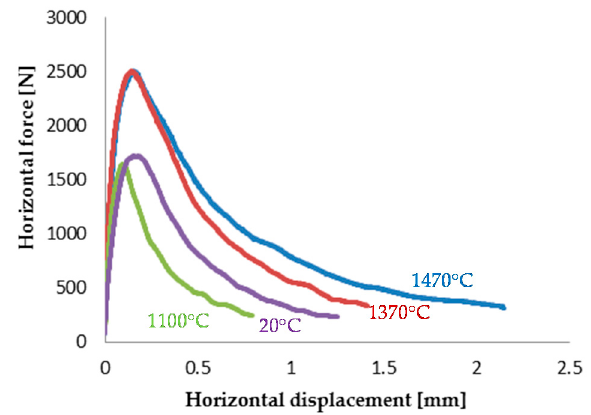
Figure 6. Load/displacement diagram of the magnesia carbon material measured at different temperatures.